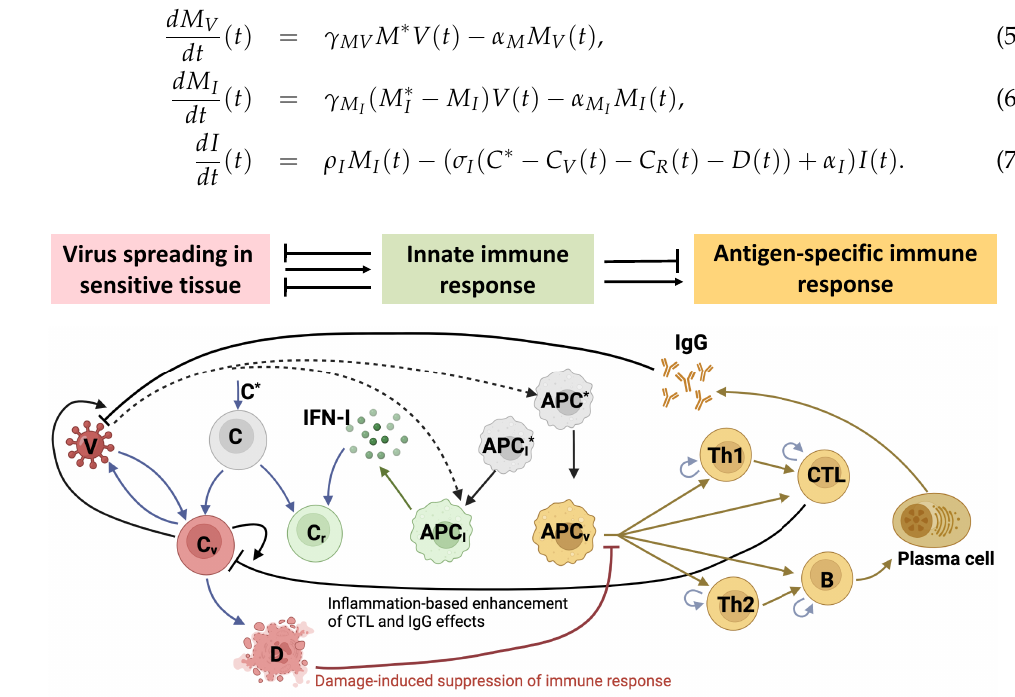
Figure 1. Biological scheme of the mathematical model of the immune response in SARS-CoV-2 infection depicting three levels of the virus interactions with the host organism. The first level is the virus ( V ) spreading in a sensitive epithelial tissue that consists of the known concentration of epithelial cells ( C ∗ ). Some of them, get infected ( C V ) and produce new viruses. The infected cells die ( D ) either due to the cytopathic effect of the virus or the CTL-mediated killing. At the second level of the virus-host interaction, the viral population is recognized by cells of the innate immune system, i.e., the type I IFN-producing cells ( APC I ) and the antigen-presenting cells ( APC V ) . The produced type I IFN makes some of the target cells protected from the viral infection ( C R ) . Free viruses are eliminated by specific antibodies ( IgG ) . Professional antigen-presenting cells activate the two subsets of CD4 T cells ( Th 1 and Th 2) participating in the regulation of the cellular ( CTL ) and humoral immune reactions comprising the third level of the virus-host interaction. B cells ( B ) differentiate into plasma cells ( P ) which secret virus-specific antibodies ( IgG ) via multiple interactions. The damage of the target organs induces suppression of the immune responses via a negative feedback. The inflammation-related enhancement of the functional effect of CTLs and antibodies on elimination of infected cells and free viruses, respectively, is parameterized in the model via the relative abundance of virus-infected cells. All viral-, humoral- or cellular components in the model either die or degrade, however, the respective processes are not shown for clarity of the